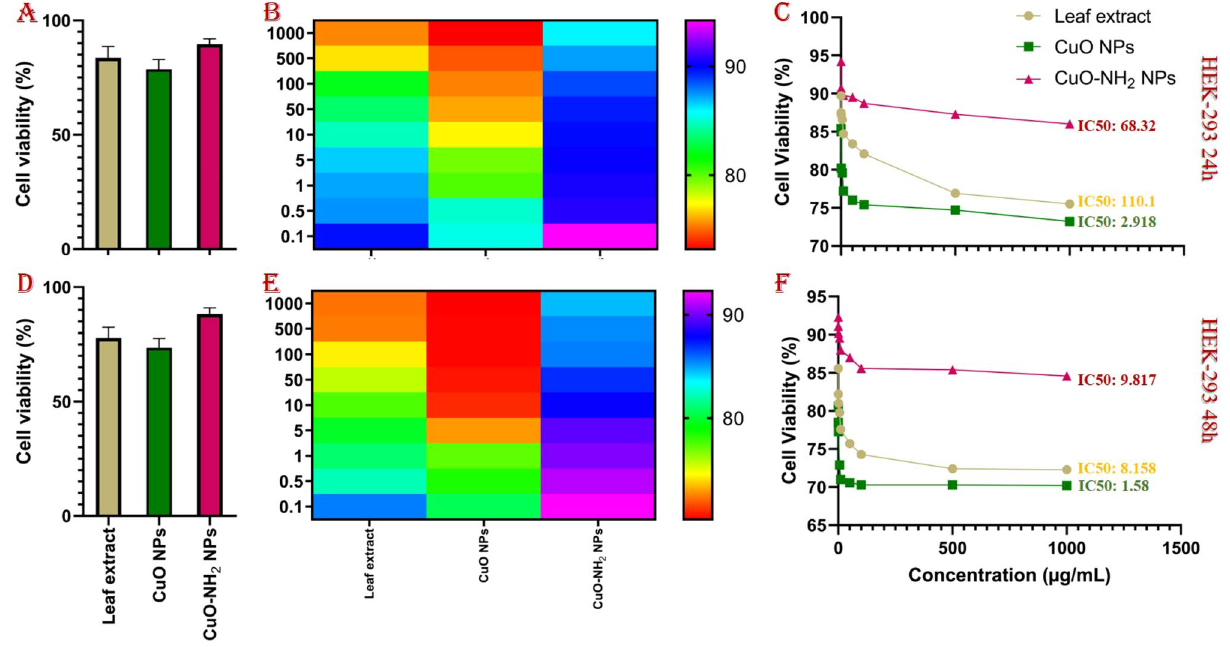
Figure 8. The average results of MTT assay after 24 h ( A ) and 48 h ( D ) of treatment on HEK-293 cell line. The heat map graphs of MTT assay with various concentration from 0.1 to 1000 µg/mL of different (nano)materials on HEK-293 after 24 h ( B ) and 48 h ( E ). The dose-dependent MTT assay results and IC-50 values on HEK-293 after 24 h ( C ) and 48 h ( F )